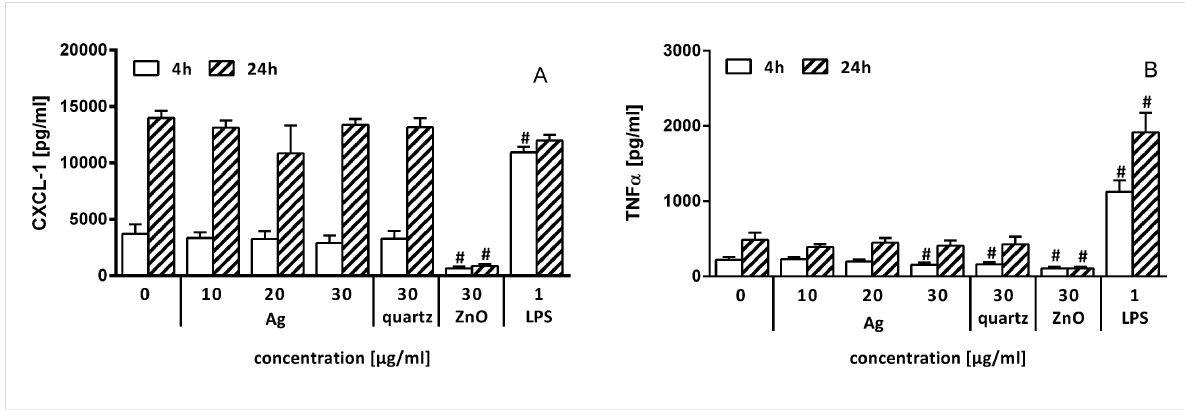
Figure 6: A: CXCL-1 levels measured in the PCLS culture medium after 4 and 24 h of incubation; B: TNF- α -levels measured in the PCLS culture medium after 4 and 24 h of incubation; n = 5; # p < 0.05 vs control determined by ANOVA on ranks with post hoc Student–Newman–Keuls test.